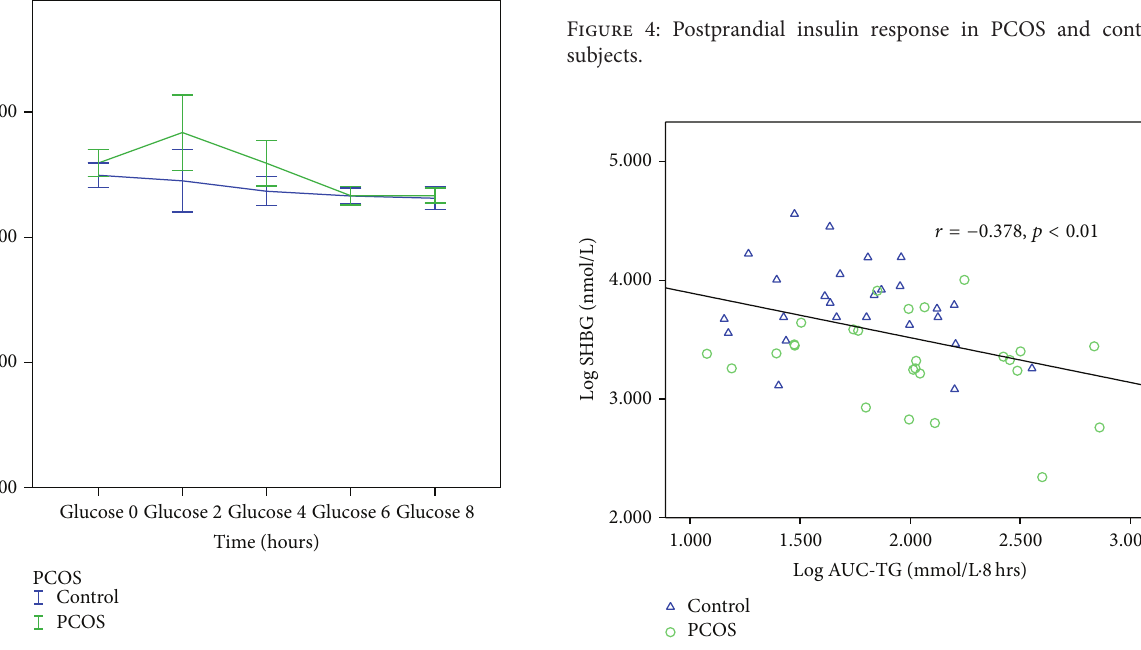
Figure 3: Postprandial glucose response in PCOS and control subjects.